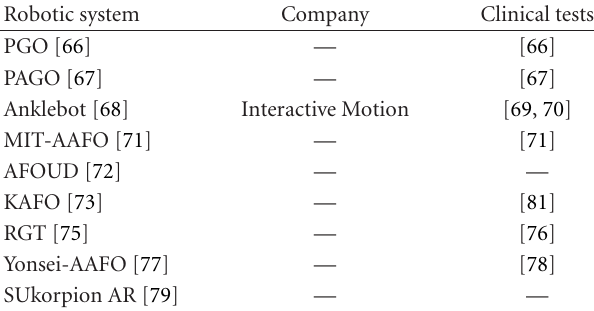
Table 6: Active foot